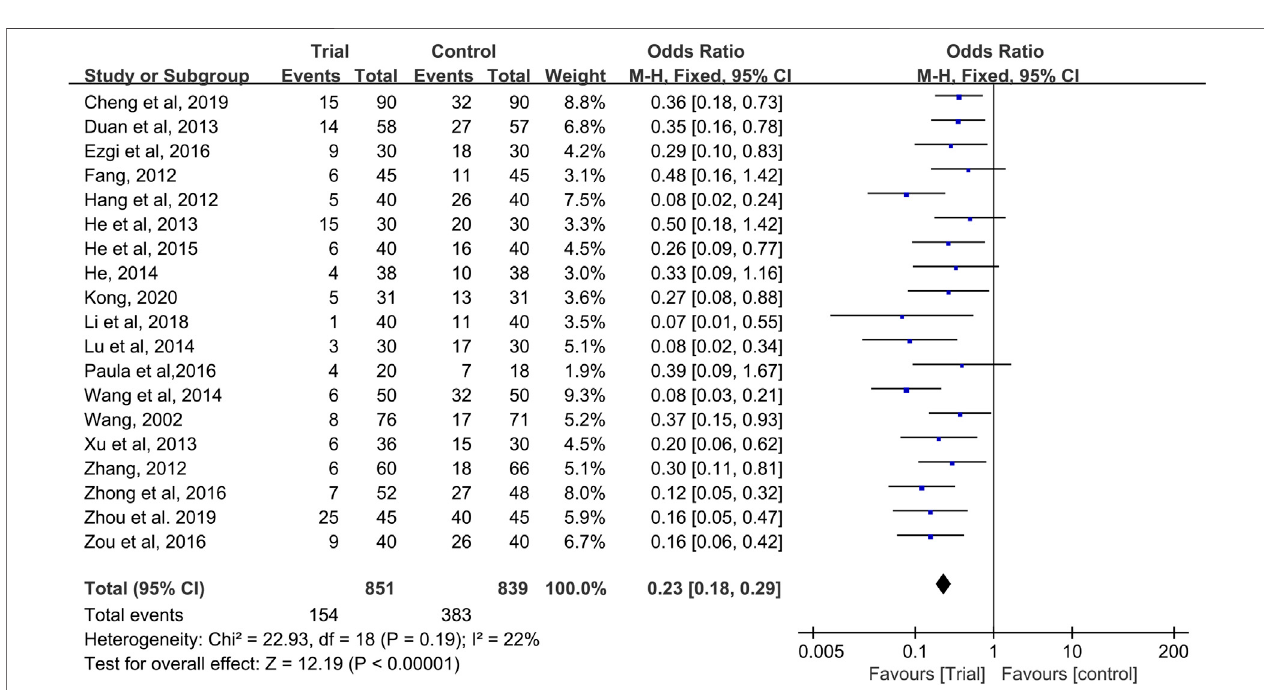
FIGURE 3 | Forest plots of incidence of CIOM.